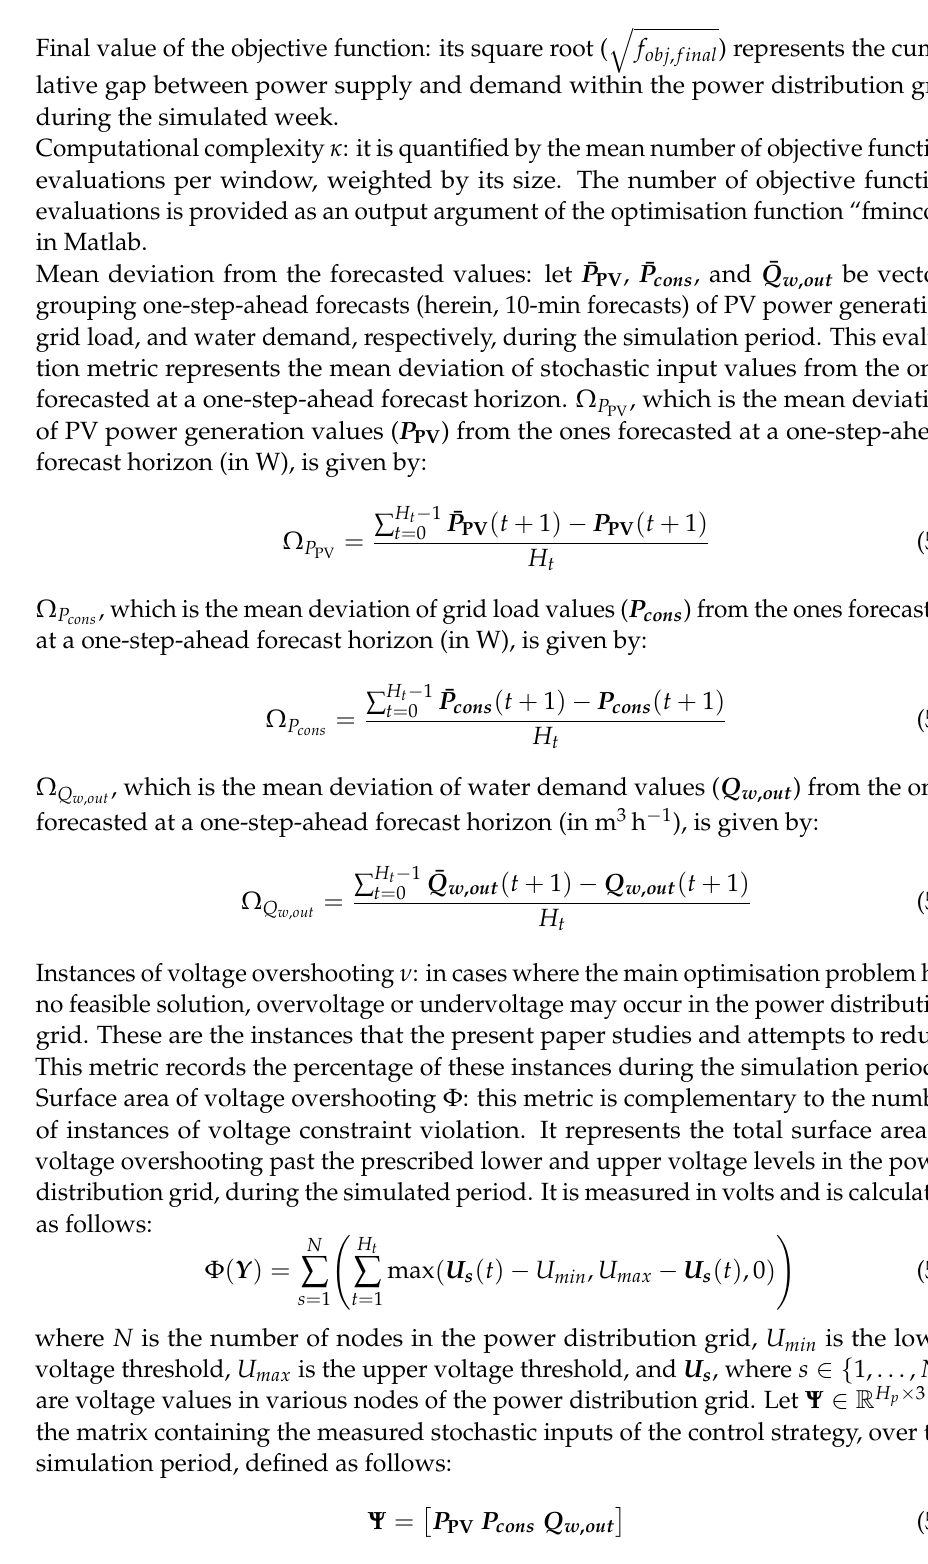
Note that voltage values across the power distribution grid are linked to the values of Ψ through Kirchhoff